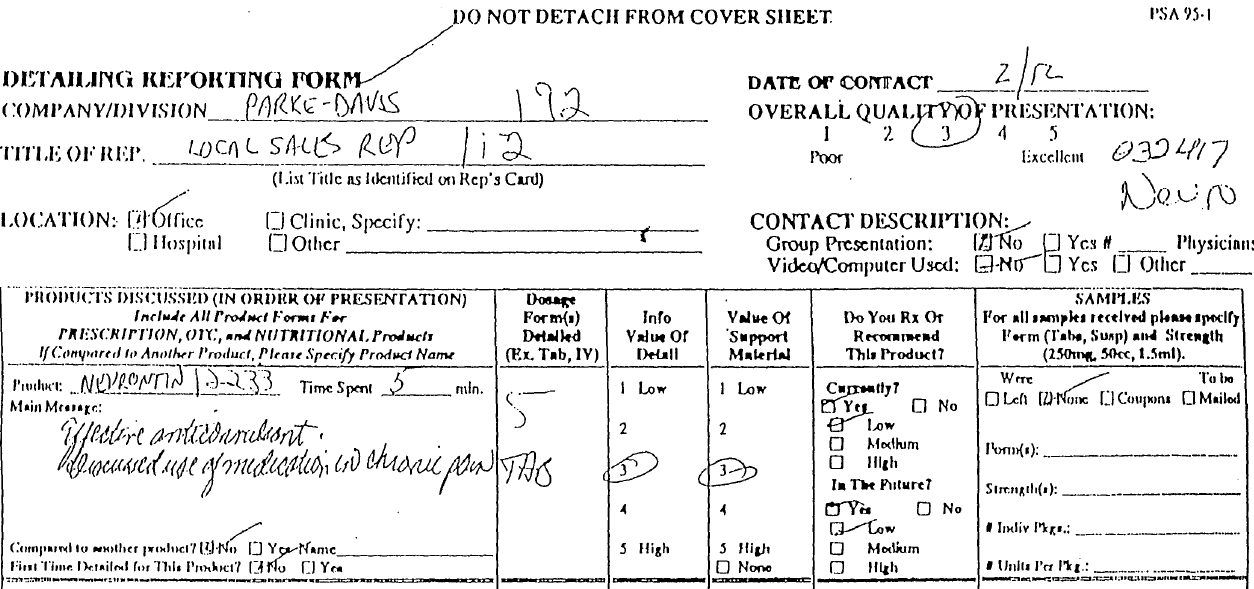
Figure 1. Detailing Reporting Form Excerpt from a detailing reporting form providing information on a detail visit for gabapentin. Some markings (e.g., ‘‘ 032417 Neuro ’’ and ‘‘ 12233 ’’ next to ‘‘ Product: Neurontin ’’ ) were annotations entered by Verispan employees to assist with coding and data entry of completed